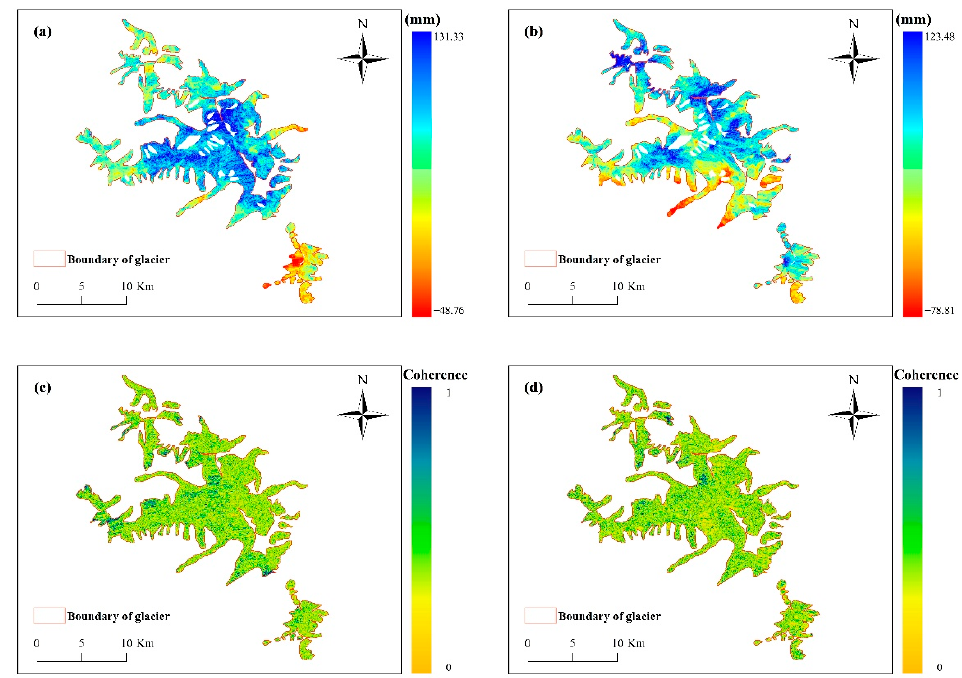
Figure 5. Azimuthal deformation results of the MAI technique, ( a ) is the result of ascending orbit, ( b ) is the result of descending orbit, ( c ) is the coherence of ascending orbit, ( d ) is the coherence of descending orbit.